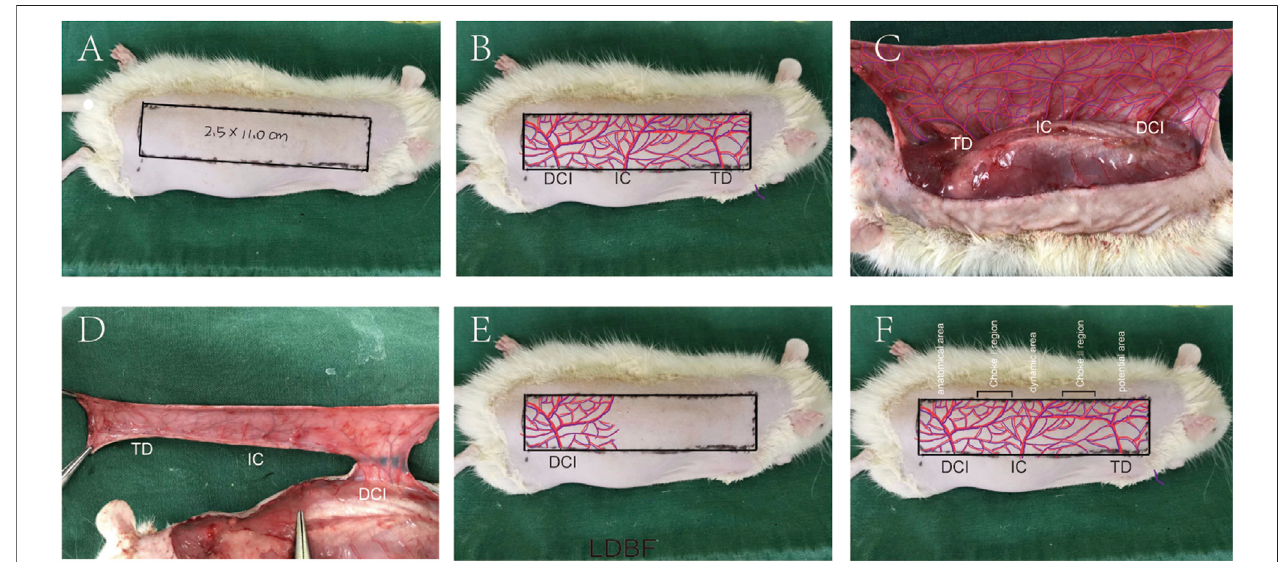
FIGURE7| Multiterritoryperforator fl approcedure. (A) A2.5 × 11.0 cmskin fl apatthebackareawasmarked. (B) Approximatedistributionofinvolvedarteries. (C) Exposedarteries:dorsalthoracic(TD),posteriorintercostal(IC),anddeepcircum fl ex(DCI)arteries. (D) ExcisionoftheTD,PIC,andpreservationoftheDCI. (E) The fl apis suturedback, and itsapproximate blood supply range isshown. (F) Multiterritory perforator fl ap areas:anatomical, dynamic, andpotential.The choke Ⅰ zone isbetween the anatomical and dynamic areas. The choke Ⅱ zone is between the dynamic and the potential